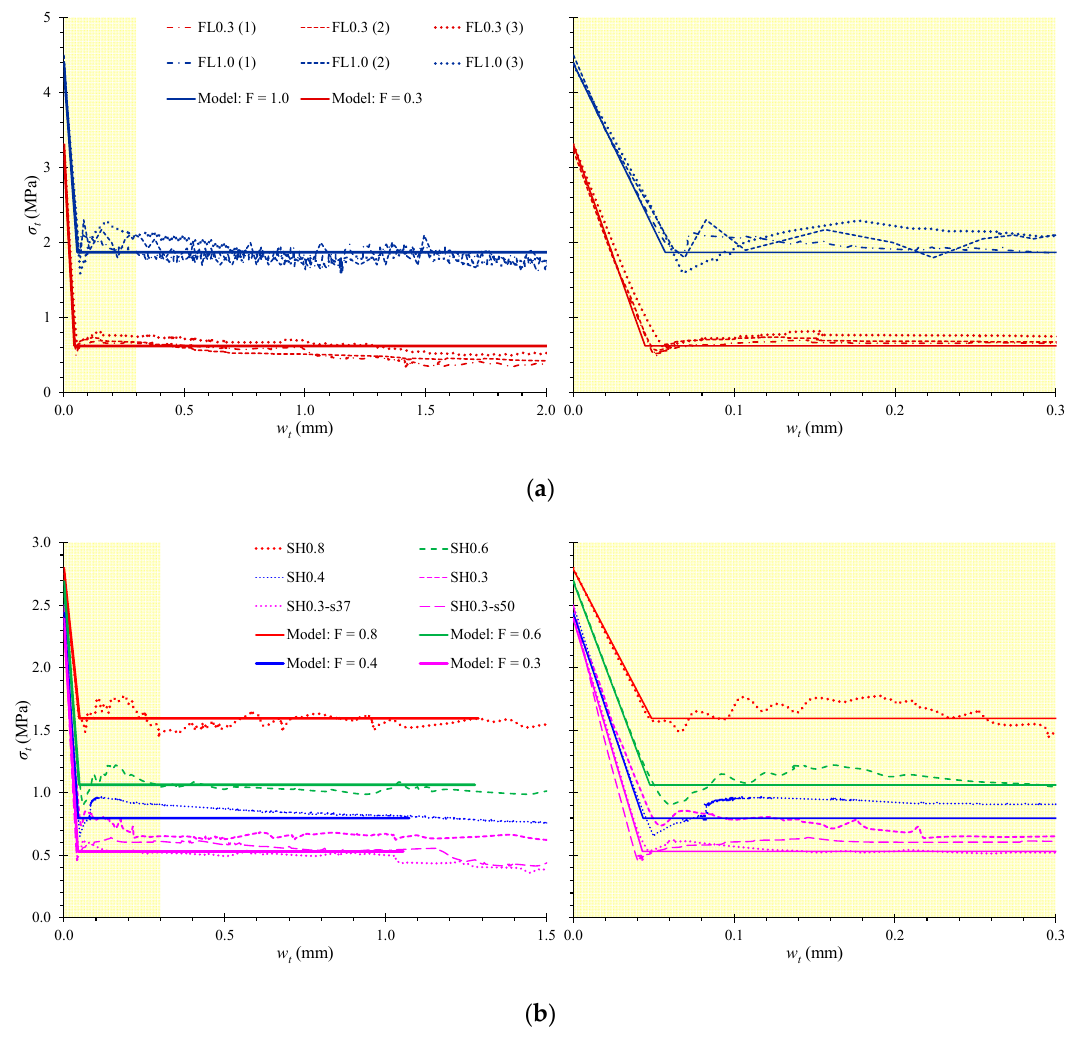
Figure 3. Tensional stress versus crack width ( σ t - w t ) behavioral curves obtained from axial direct tension tests and predicted from the proposed model: ( a ) SFRC mixtures of the slender beams (three tensional specimens from each SFRC mixture); ( b ) SFRC mixtures of the deep beams.